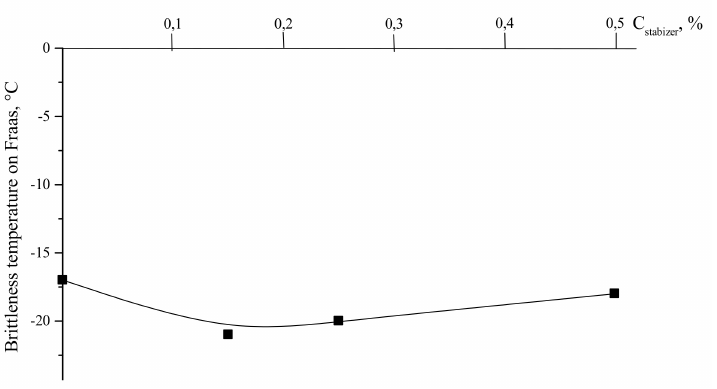
Figure 6. Dependence of brittleness temperature on Fraass on petroleum road stabilizer concentra- tion. Table 6. The test results of the modified bitumen at different concentrations of the